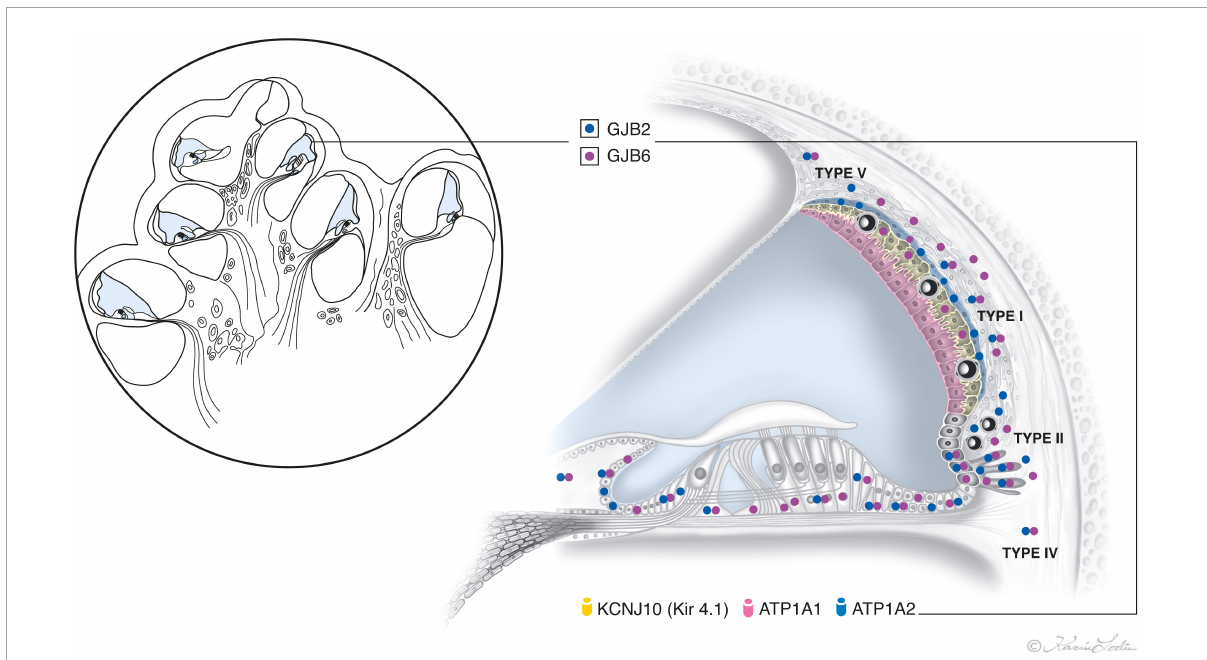
FIGURE12 Illustration showing the relative distribution of GJB2 and GJB6 gene transcript puncta in the epithelial and connective tissue networks in the human cochlea. The location and number of transcripts vary among cells in the lateral wall, with the largest number appearing in the outer sulcus cells, root cells, and types I and II fibrocytes and basal cells. GJB2 dominates in the basal cell layer. The intermediate cells only express GJB6 . No GJB2 and GJB6 gene transcripts are expressed in the marginal and sensory hair cells. Two GJ systems exist in the HC – Epithelial and connective tissue. The epithelial system consists of interdental cells of the spiral limbus, supporting cells of the organ of Corti (OC), bordering cells, phalangeal cells, Hensen cells, Deiters’ cells, inner and outer sulcus cells with root cells projecting into the spiral ligament, and marginal cells of the stria vascularis. The connective tissue system consists of fibrocytes of the spiral limbus, lateral wall including the basal and intermediate cells of the stria vascularis (SV), suprastrial fibrocytes, and mesenchymal cells lining the scala vestibuli and supralimbal cells (Kikuchi et al.,